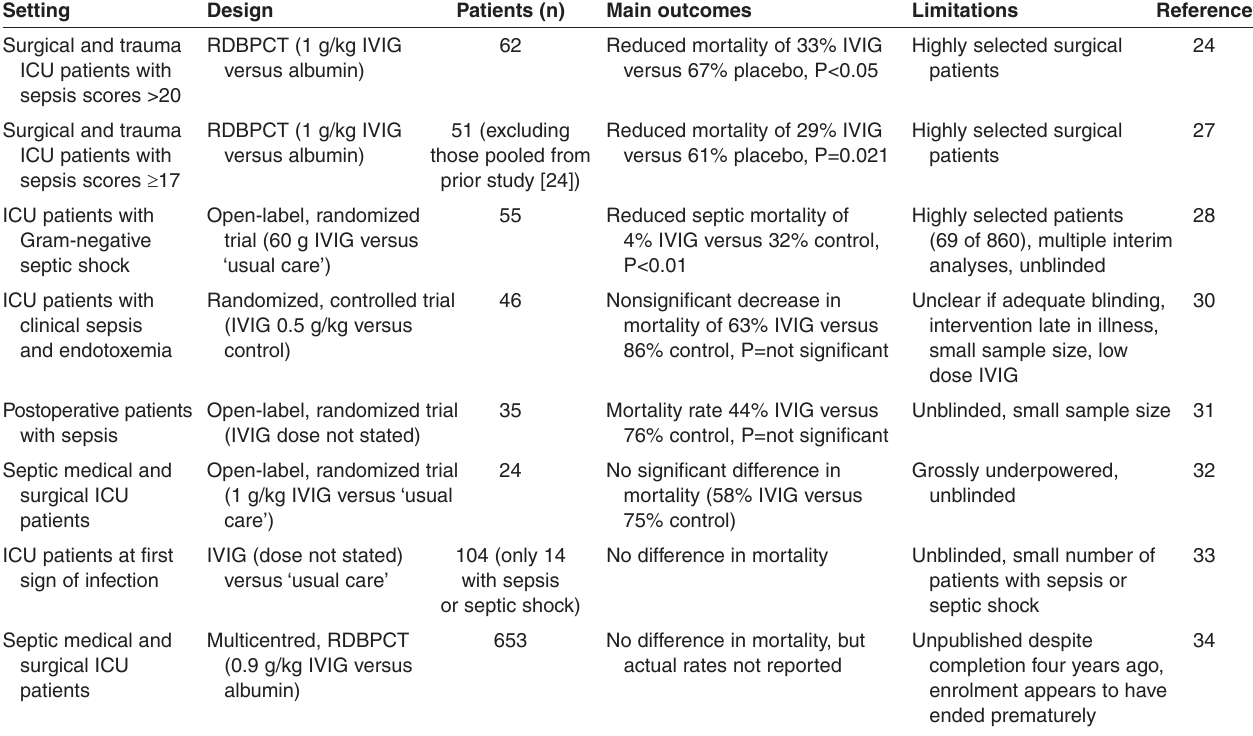
TABLE 2 Randomized trials of intravenous immunoglobulin (IVIG) for the treatment of sepsis and septic shock in the intensive care unit (ICU) Setting